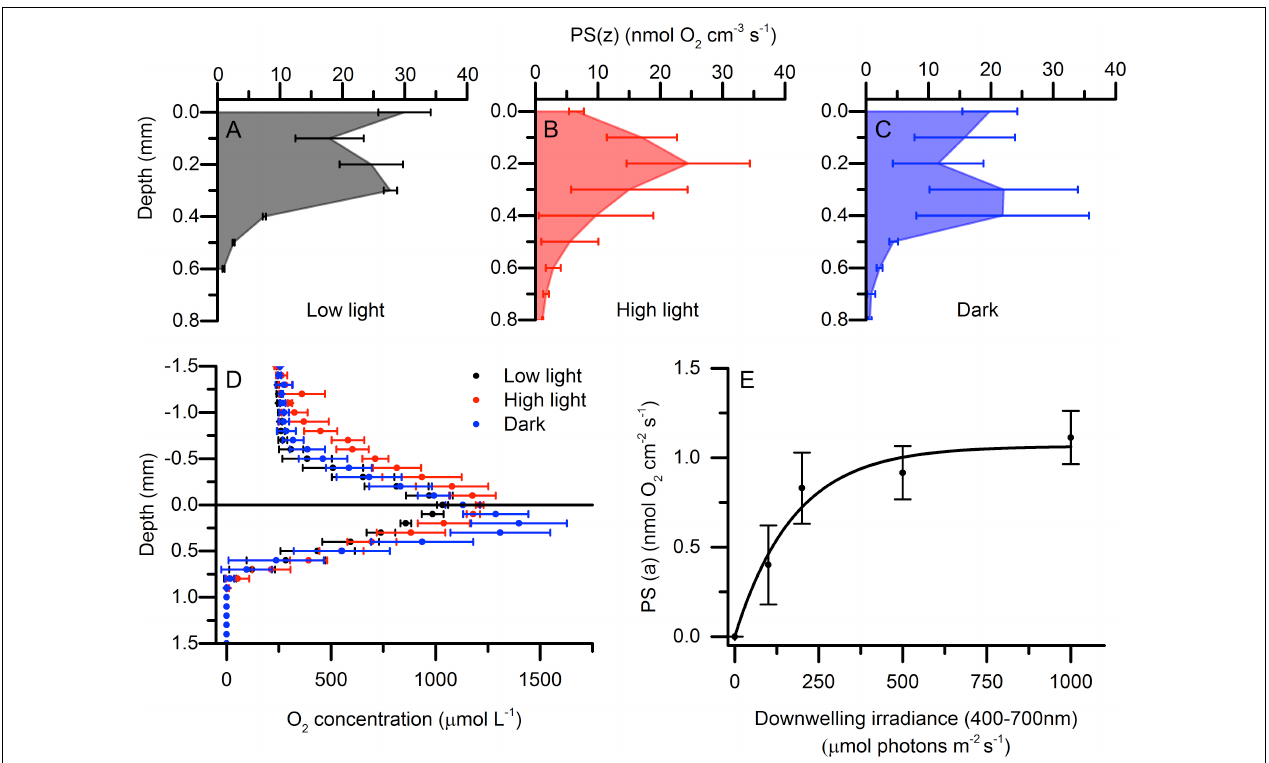
FIGURE 5 | Depth distribution of volumetric gross photosynthesis rates [PS(z)] under an incident photon irradiance of 1000 µ mol photons m − 2 s − 1 . Measurements were done in a low light-acclimated (A) , high light-acclimated (B) , and dark-acclimated (C) microbial mat. Data points with error bars represent means ± 1 SD ( n = 3). (D) Depth profiles of O 2 concentration in low light, high light, and dark acclimated microbial mats measured under a downwelling photon irradiance (400–700 nm) of 1000 µ mol photons m − 2 s − 1 (means ± 1SD; n = 3). (E) Areal photosynthetic rates [PS(a)] vs. irradiance curve using 30 min acclimation to each irradiance (means ± 1 SD; n = 3). Data was fitted with an exponential saturation model (Webb et al.,